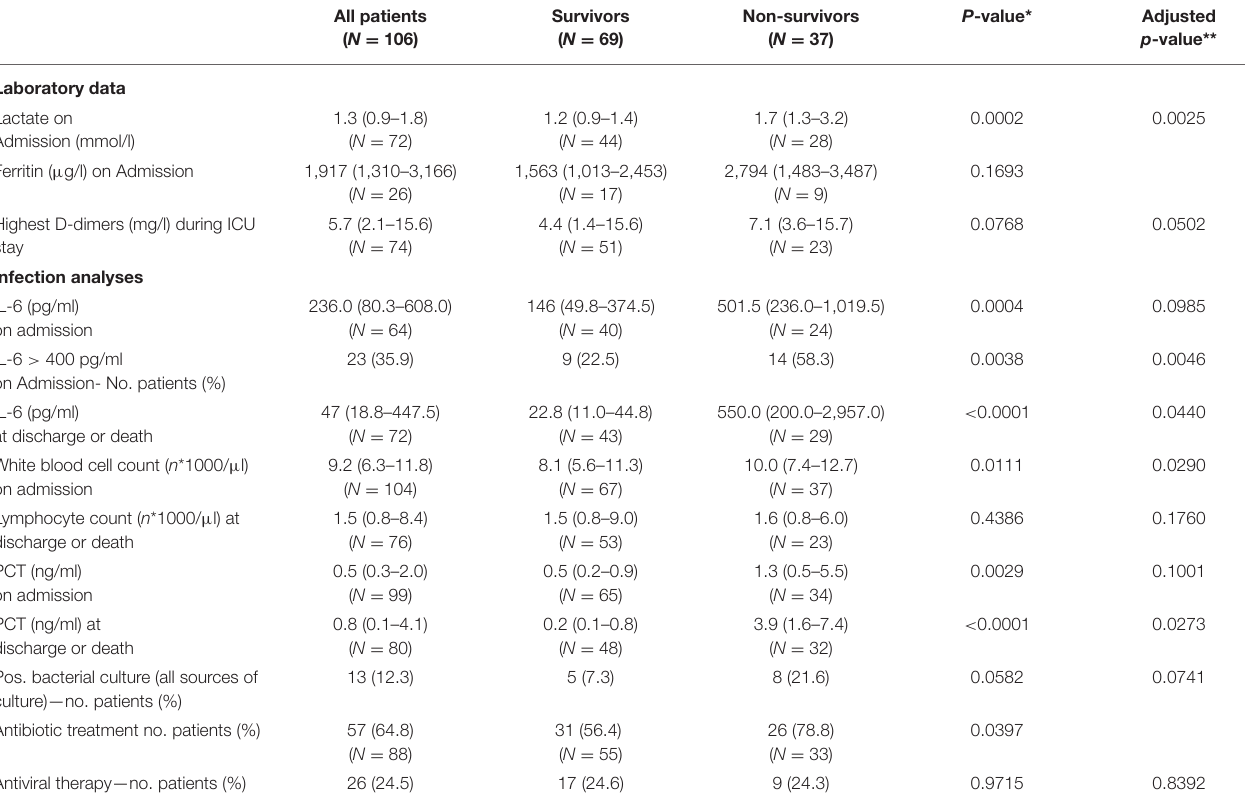
TABLE 2 | Laboratory and microbiological findings.